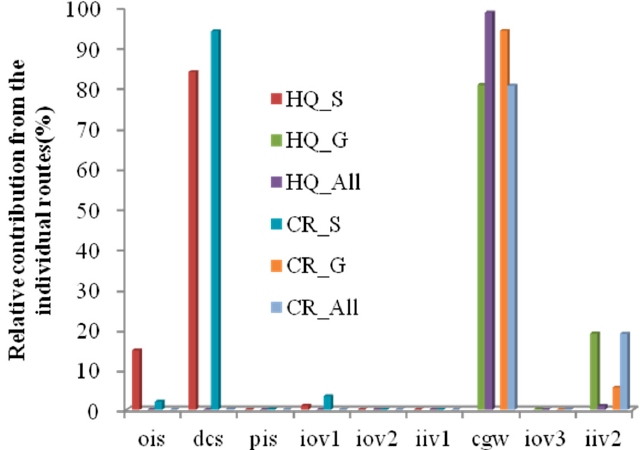
Table 4. Contaminants of concern (COCs) concentrations applied for risk characterization at the Luhe site. Parameter Symbol Benzene Toluene Xylenes C